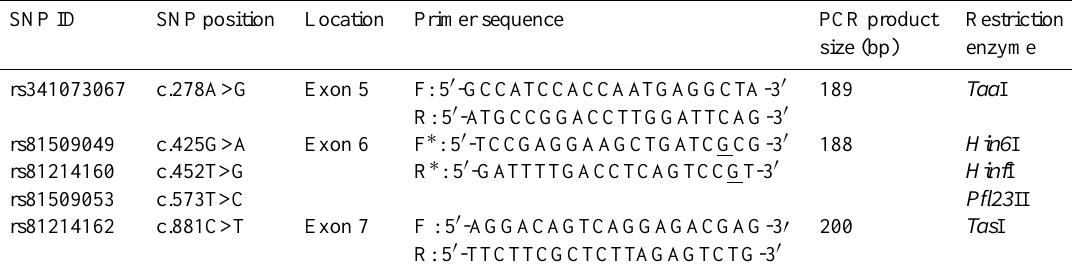
Table 1. Primer sequence, PCR product size and restriction enzymes of SNPs markers of the porcine OPN gene. SNP ID SNP position Location Primer sequence PCR product Restriction